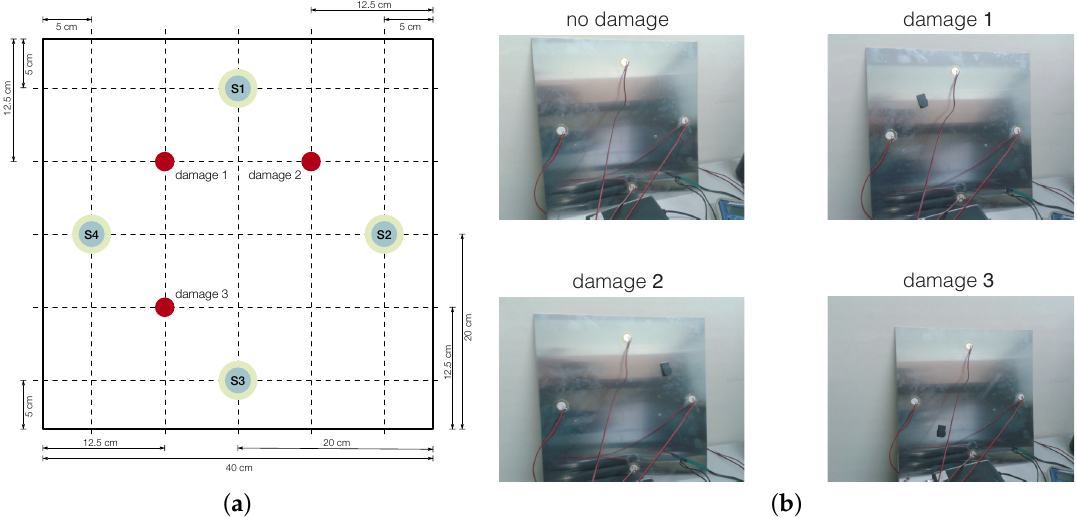
Figure 4. ( a ) Aluminum plate with four piezoelectric sensors (S1, S2, S3, and S4); ( b ) the four structural states